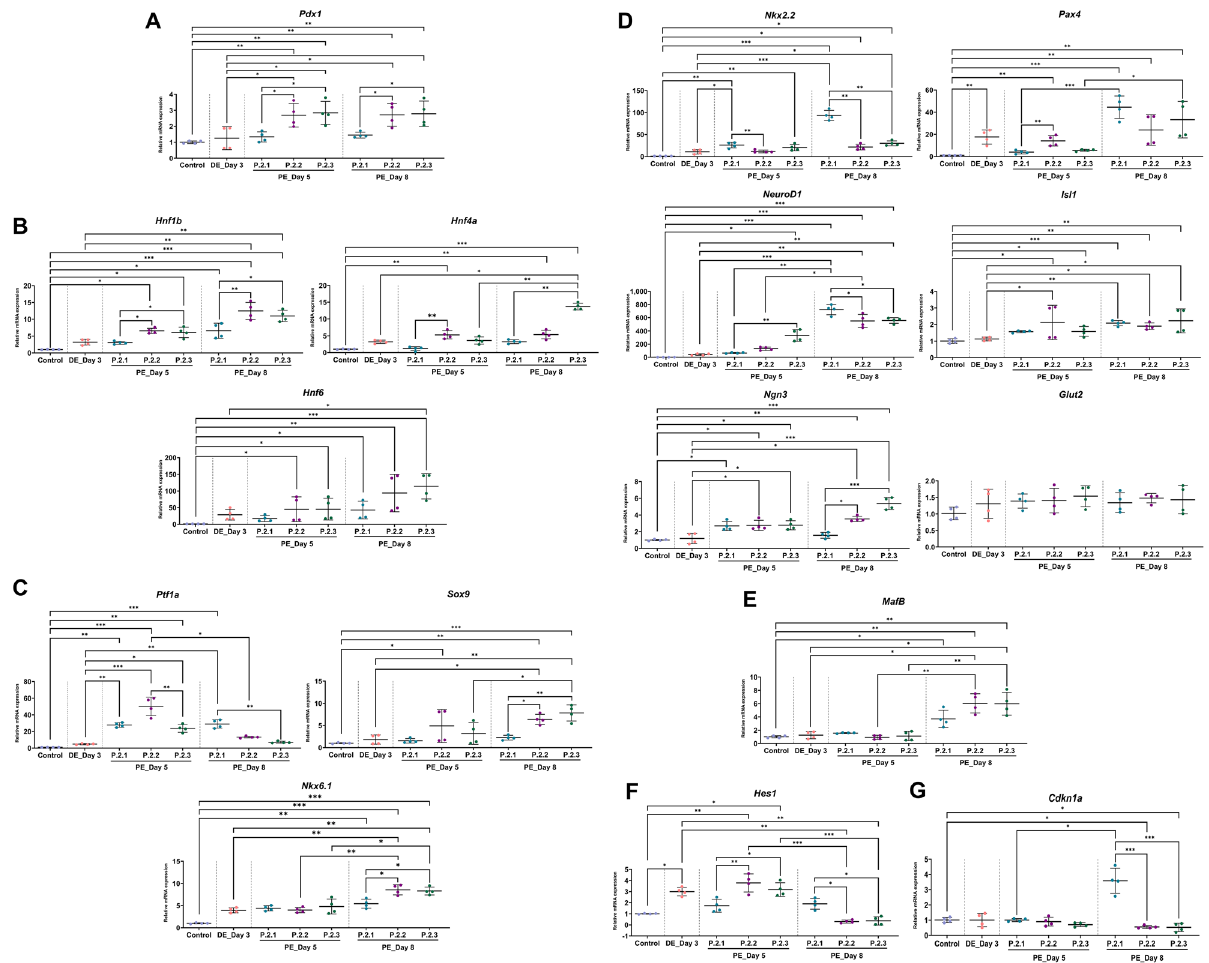
Figure 4. PE-related marker expression. The expression of mRNA markers relating to pancreatic endoderm ( A ), primitive gut and posterior foregut ( B ), pancreatic multipotent progenitor ( C ), endocrine precursors ( D ), immature pancreatic endocrine ( E ), caNotch pathway target gene ( F ), and a cell cycle regulator ( G ) was analyzed by RT-qPCR at day 3, 5 and 8 post-induction. Relative mRNA expression was normalized with the reference gene, and the undifferentiation control. Bars indicates the significant differences (*, p value < 0.05; **, p value < 0.01; ***, p value <